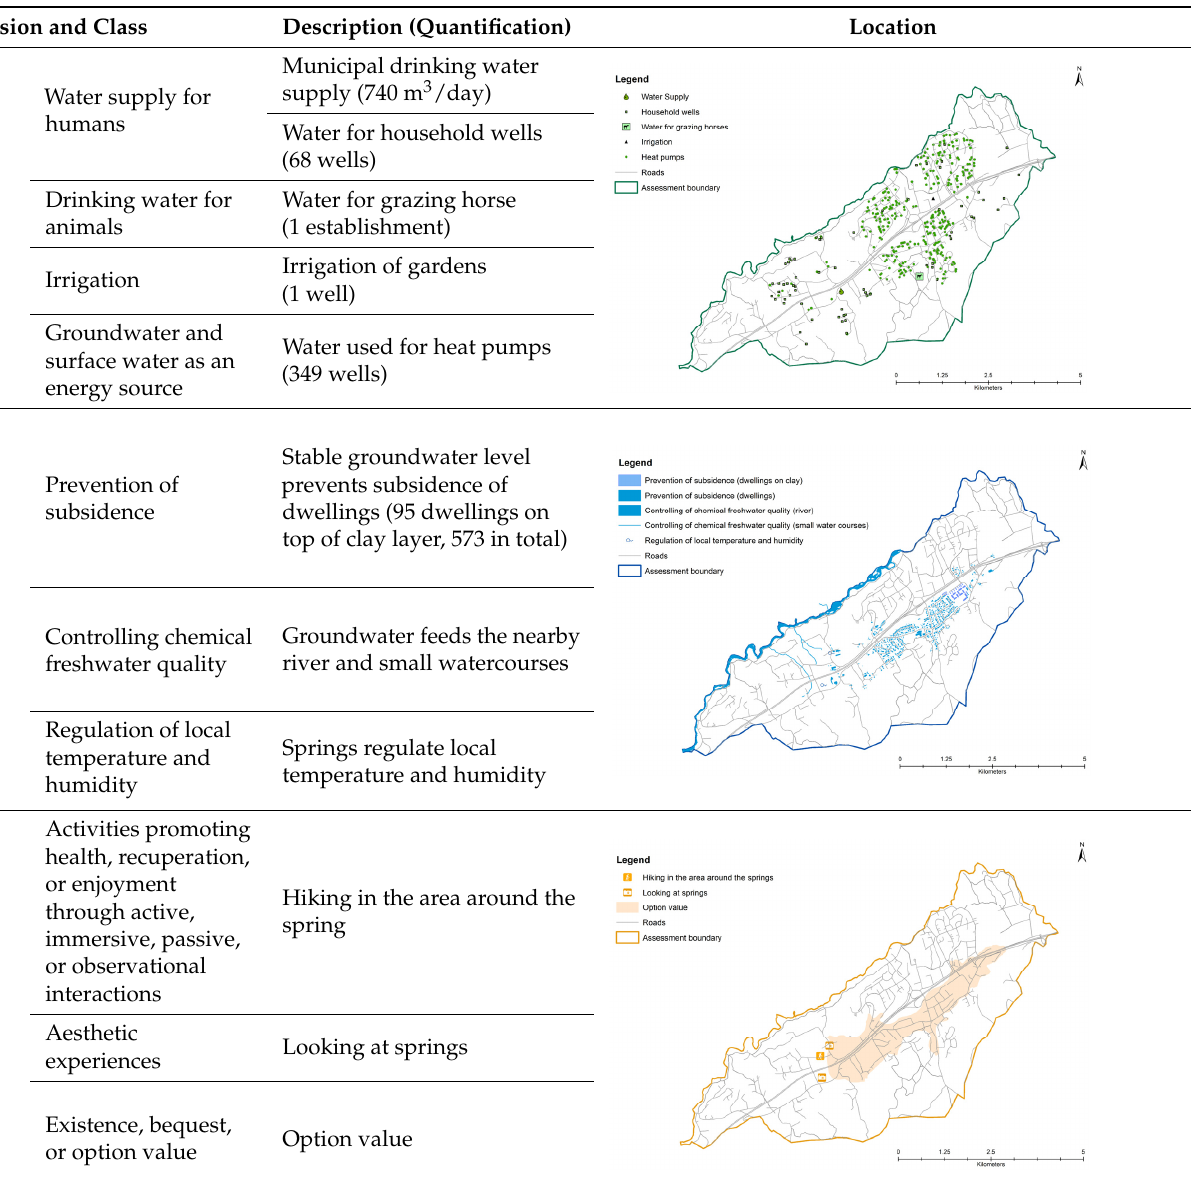
Table 6. Identified water system services from the Skallsjö aquifer.